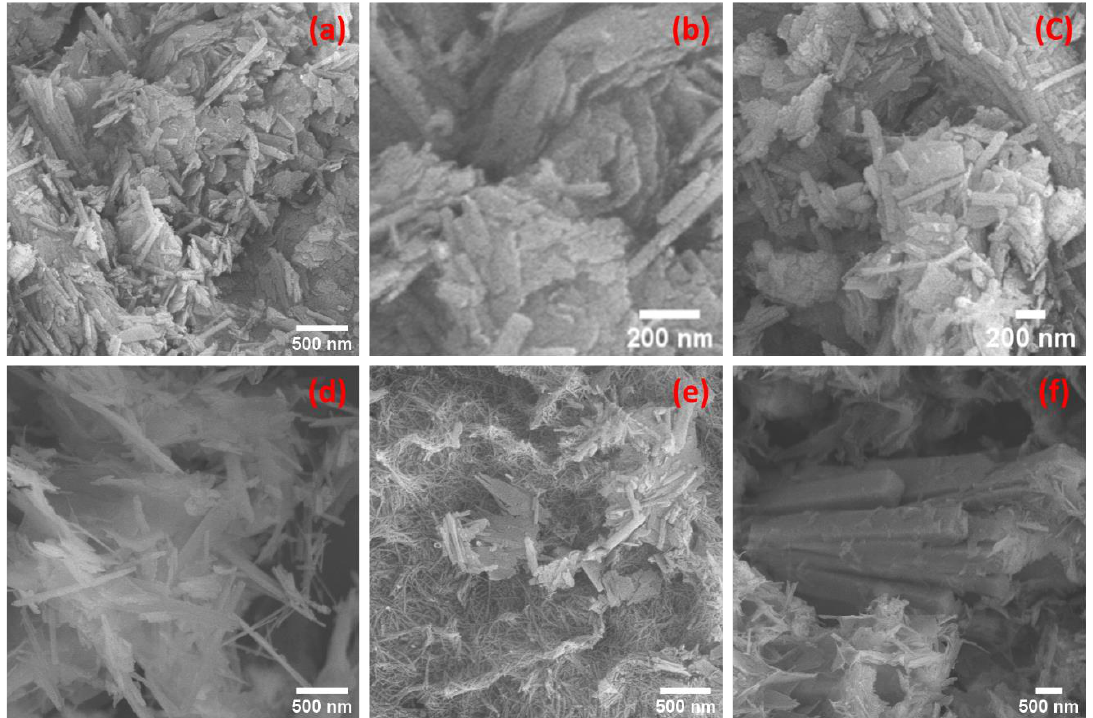
Figure 5. ( a – f ) FESEM images at different locations showed the mixed structures of zeolite and serpentine in the Zeo/Serp (2:1) composite sample after hydrothermal treatment at 250 °C for 6 h.